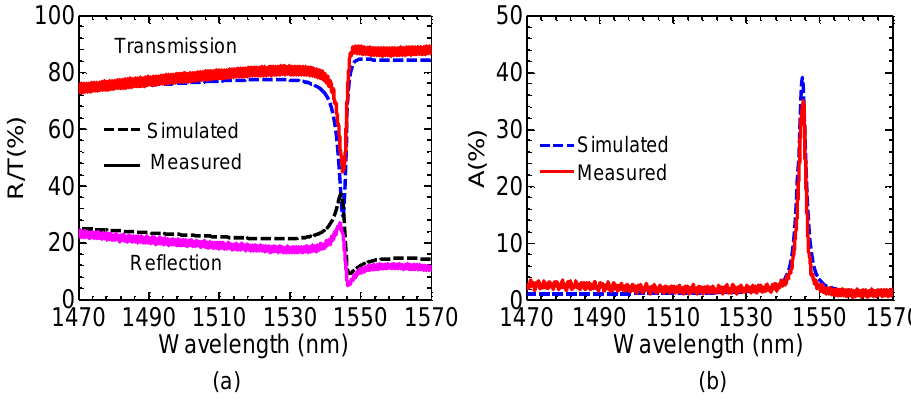
Figure 16. ( a ) Measured (solid line) and simulated (dashed line) transmission (T) and reflection (R) spectra for the monolayer graphene on Si PCS without back reflector; and ( b ) Measured and simulated absorption (A) spectra for the monolayer graphene on Si PCS without back reflector. Reproduced with permission from